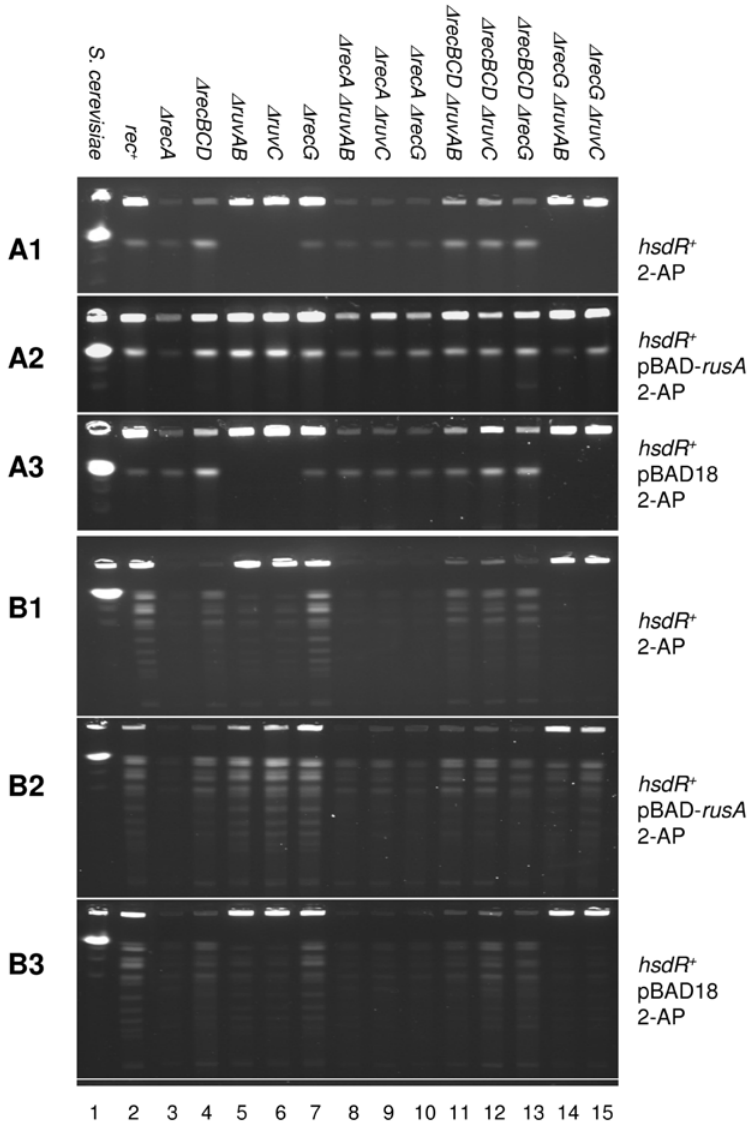
Figure 2. Pulsed field gel analysis of chromosomal DNA following treatment of D clpX mutant strains with 2-AP, prior to cleavage with Not I (A1, A2 and A3) and after cleavage with Not I (B1, B2 and B3). The S. cerevisiae chromosomes are shown in lane 1 as a molecular size standard, confirming the compression of linear fragments of 450 kb to 1.5 mb into a single band under the conditions used. This band of yeast chromosomes runs at the same position as linearized E.coli DNA (4.5 mb). (A1 and B1) Lanes 2–15, release of linear DNA into pulsed field gels from rec + and recombination defective strains: DL1902, DL2656, DL2659, DL3179, DL3184, DL2600, DL3201, DL3207, DL2670, DL3204, DL3208, DL2673, DL3200, DL3206. (A2 and B2) Lanes 2–15, release of linear DNA into pulsed field gels from rec + and recombination defective strains containing the plasmid pBAD- rusA : DL3122, DL3217, DL3123, DL3218, DL3219, DL3220, DL3221, DL3222, DL3223, DL3224, DL3225, DL3226, DL3227, DL3228. (A3 and B3) Lanes 2–15, release of linear DNA into pulsed field gels from rec + and recombination defective strains containing the plasmid pBAD18: DL3251, DL3252, DL3253, DL3254, DL3255, DL3256, DL3257, DL3258, DL3259, DL3260, DL3261, DL3262, DL3263, DL3264.